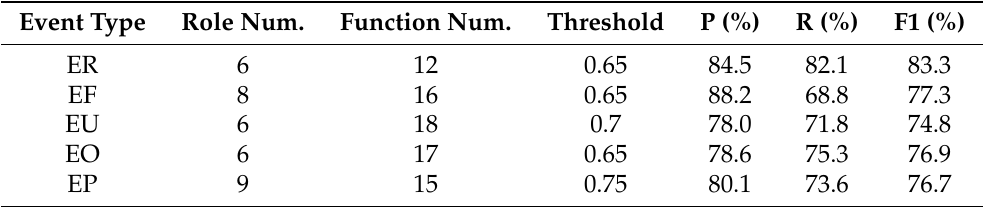
Figure 7. Threshold’s influence on the F1 value of the classification model. Table 4. Performance of event labeling on five types of event, where Role Num. represents the number of role of an event type, Function Num. represents the number of function for labeling an event type, and Threshold is the classification threshold in event labeling.